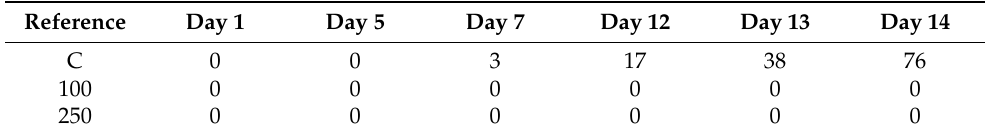
Table 3. Percentage of infected strawberries in the active packaging systems containing 0 (control), 100, and 250 µ L of trans-2-hexenal (HXAL) in the cellulosic pad. Reference Day 1 Day 5 Day